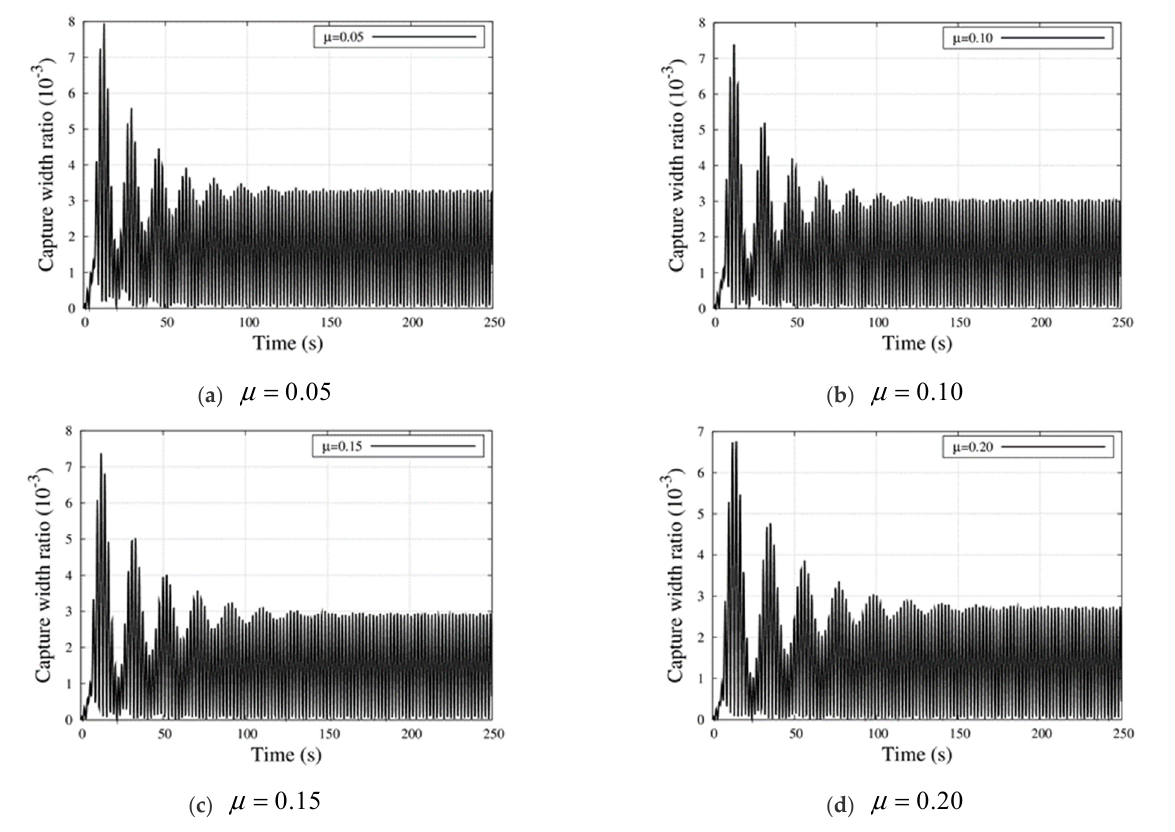
Figure 15. The capture width ratio of the MJWEC with different dissipation coefficients.